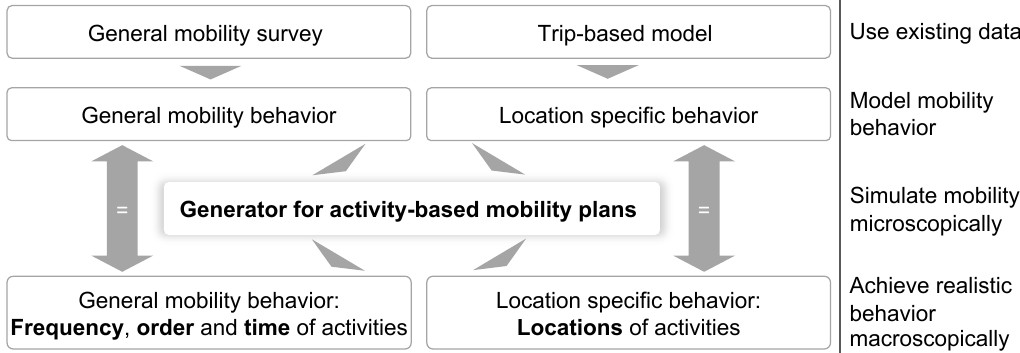
Figure 3. Overview of input and output requirements on